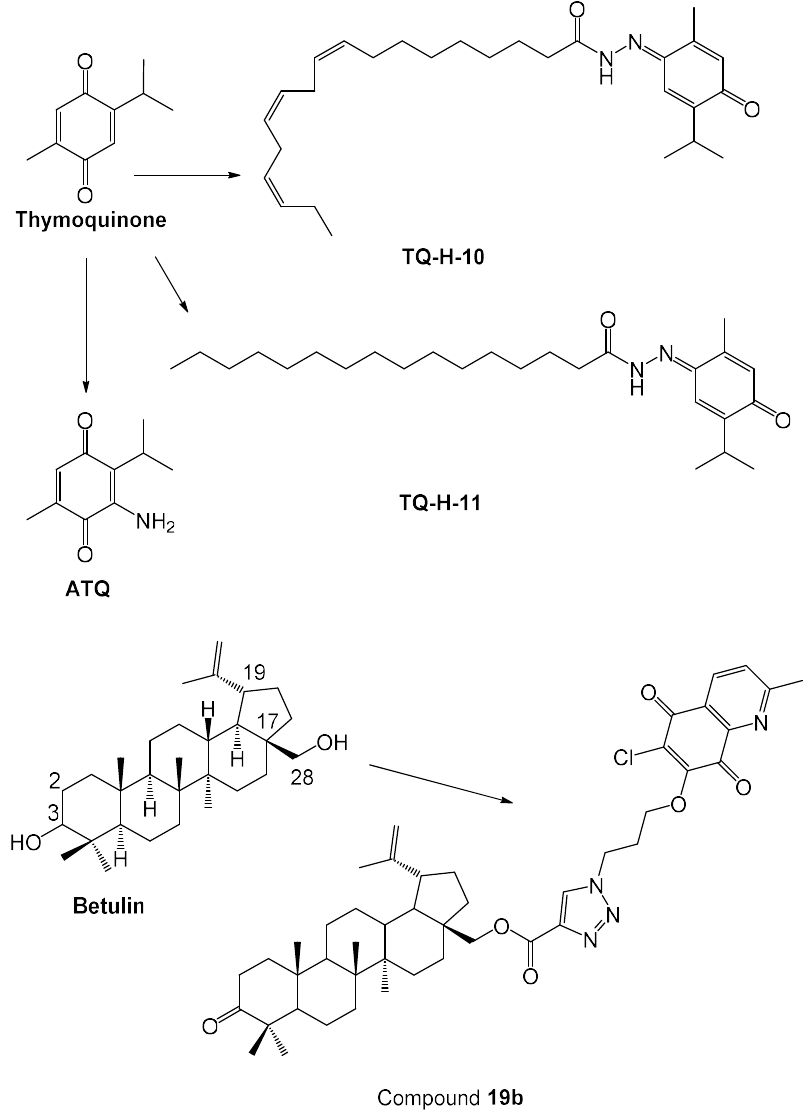
Figure 11. Thymoquinone and betulin analogs as anti-colorectal cancer agents. Apoptosis is pivotal in tissue homeostasis, particularly in gastrointestinal tract and immune system. In addition, apoptosis induction in cancer cells is a promising strategy for the treatment of cancer. In the early stages of cancer, cancer cells are more sensitive to agents, which stimulate apoptosis. Then, these cells start to become resistant to apoptotic stimuli [43–46]. Therefore, there is an urgent need to discover more potent anticancer agents that also induce apoptosis in cancer cells. Some quinone-based natural compounds were evaluated for their apoptotic effects on colorectal cancer cells. Seetha et al. [21] per-